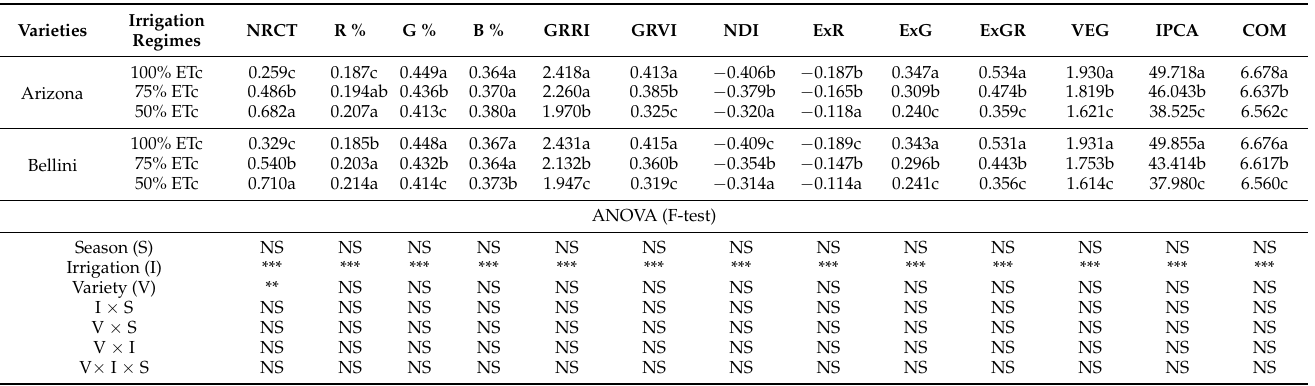
Means followed by the same letter are not significantly different from one another based on Duncan’s multiple range test at a p ≤ 0.05 significance level. NS, **, and *** indicate non-significant, significant at p ≤ 0.01, and highly significant p ≤ 0.001 probability level, respectively. The full names of the abbreviations of RGB imagery indices are listed in Table